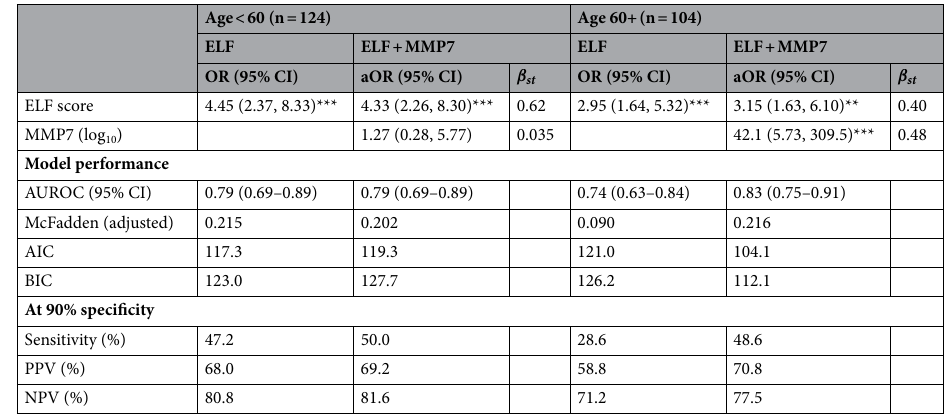
Table 4. Performance of ELF and ELF + MMP7 models for predicting LSM ≥ 8.2 by age group. Logistic regression. βst: standardised coefficient, AUROC: area under the receiver operating curve, AIC: Akaike information criterion, BIC: Bayesian information criterion, PPV: positive predictive value, NPV: negative predictive value, LR+ : positive likelihood ratio, LR−: negative likelihood ratio. **p < 0.01, ***p < 0.001.